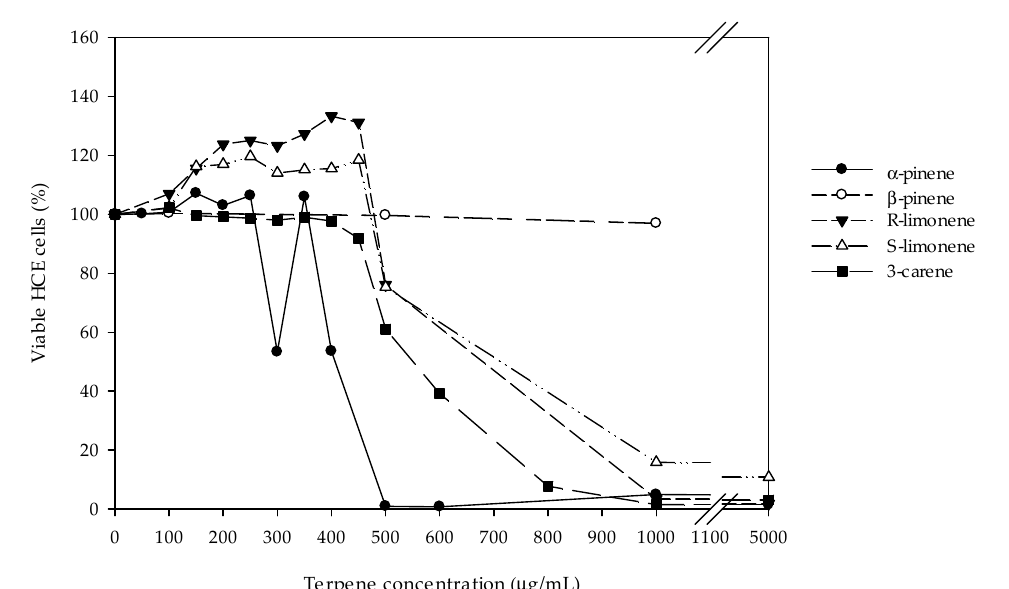
Figure 2. Cytotoxicity results for α - and β -pinene, R- and S-limonene, and 3-carene in the HCE cell model measured with a WST-1 test. The values represent average cell viabilities from one to three repeated measurements with monoterpene concentrations of 0–5000 µg/mL. Results obtained with control cells were set as 100%. Table 1. The half-maximal inhibitory concentration (IC50) of monoterpenes. Terpene IC50 α